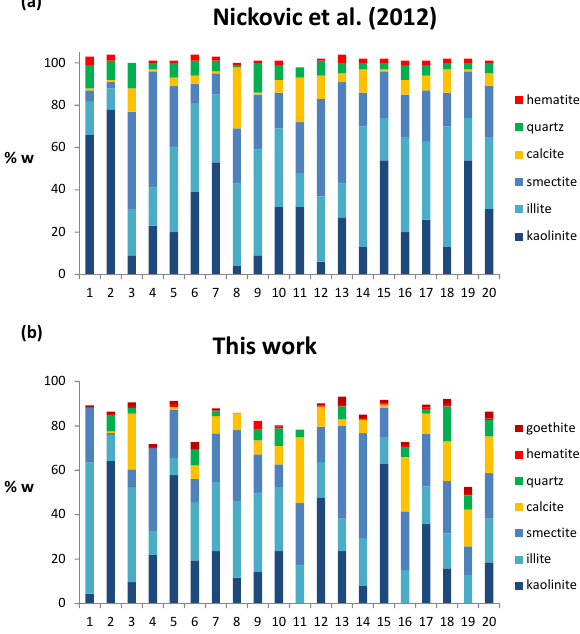
Fig. 13. Mean mineralogical composition of 20 FAO soils types: (a) Claquin et al. (1999) and Nickovic et al. (2012) and (b) this